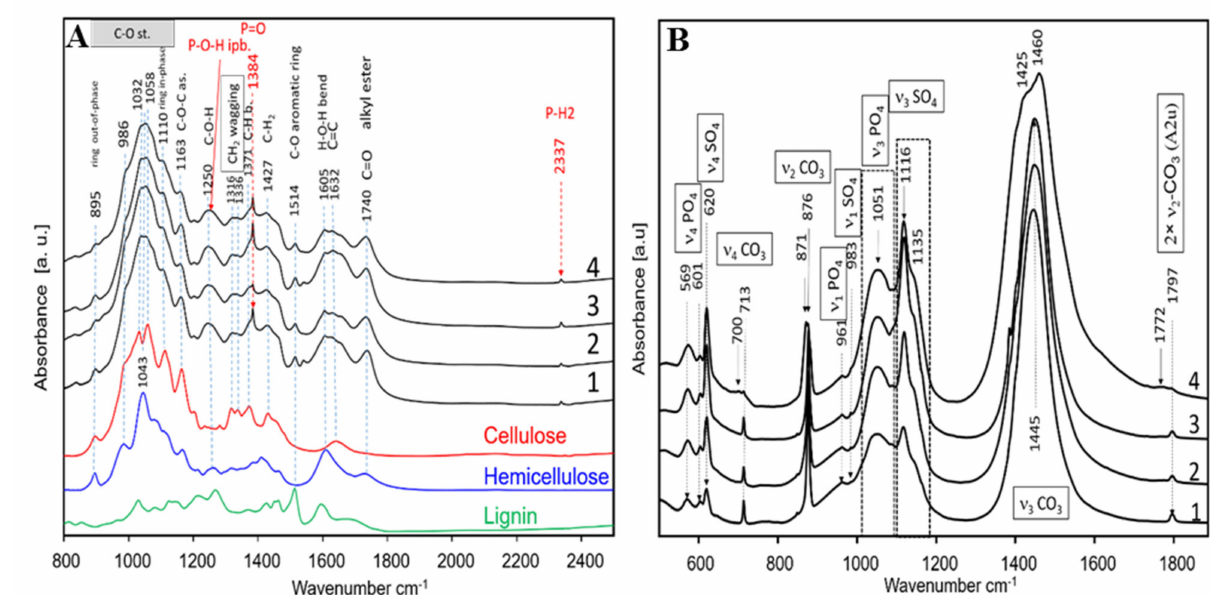
Figure 5. Infrared spectra of ( A ) the straw samples in the range 800–2500 cm − 1 and ( B ) ash samples in the range 500–1900 cm − 1 . Razinieh and Della samples taken at maturity from plants grown in phosphorous-poor soil are labelled 1 and 2, respectively. Corresponding samples grown in phosphorous-rich soil are labelled 3 and 4, respectively. In addition, IR spectra of the straw organic constituents: cellulose, hemicellulose (xylan), and lignin, are shown in Figure